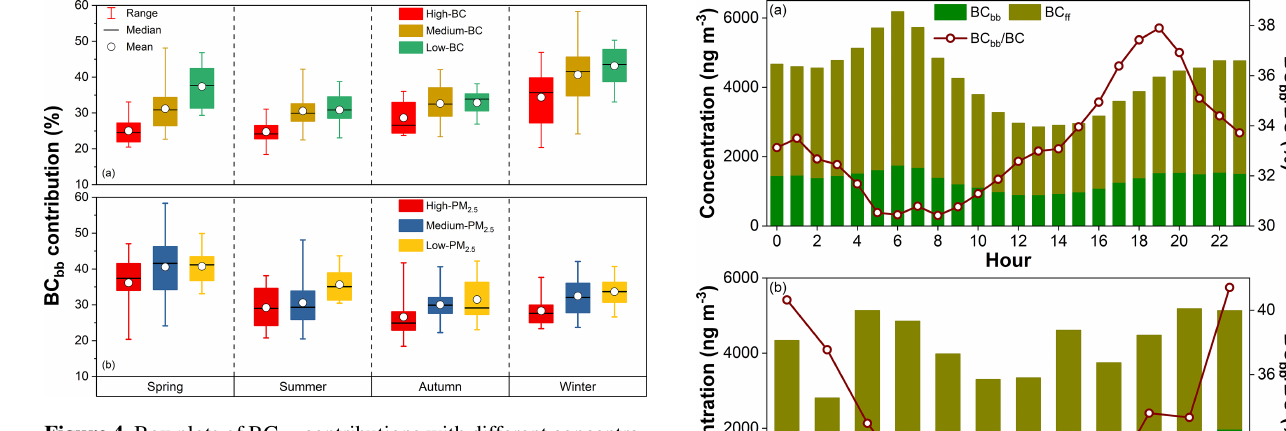
Figure 4. Box plots of BC bb contributions with different concentra- tions of (a) BC and (b) PM 2 . 5 in different seasons.